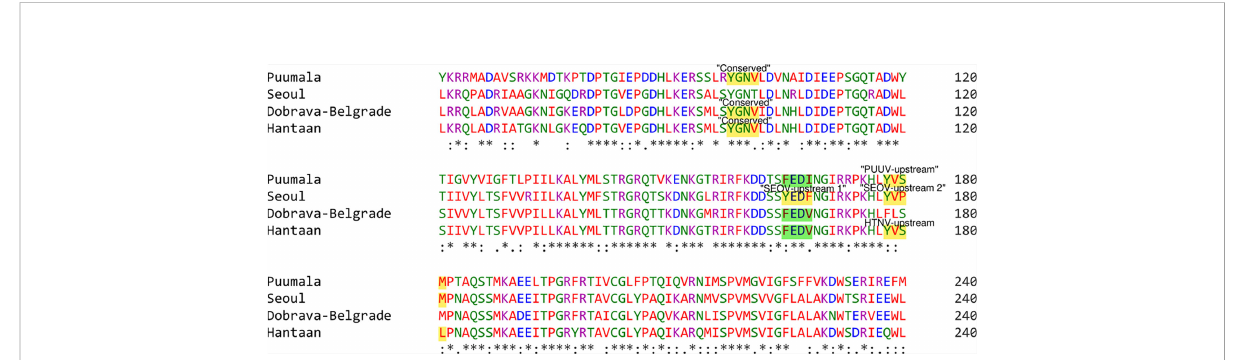
FIGURE 3 Illustrative representation of YXX F [I/L/M/F/V] motifs and YXX F -like tetrapeptides within viral sequences. YXX F [I/L/M/F/V] motifs are highlighted with yellow color and the YXX F -like tetrapeptides are highlighted with green color. Stars, amino acid sequence similarity; colons, amino acid sequence